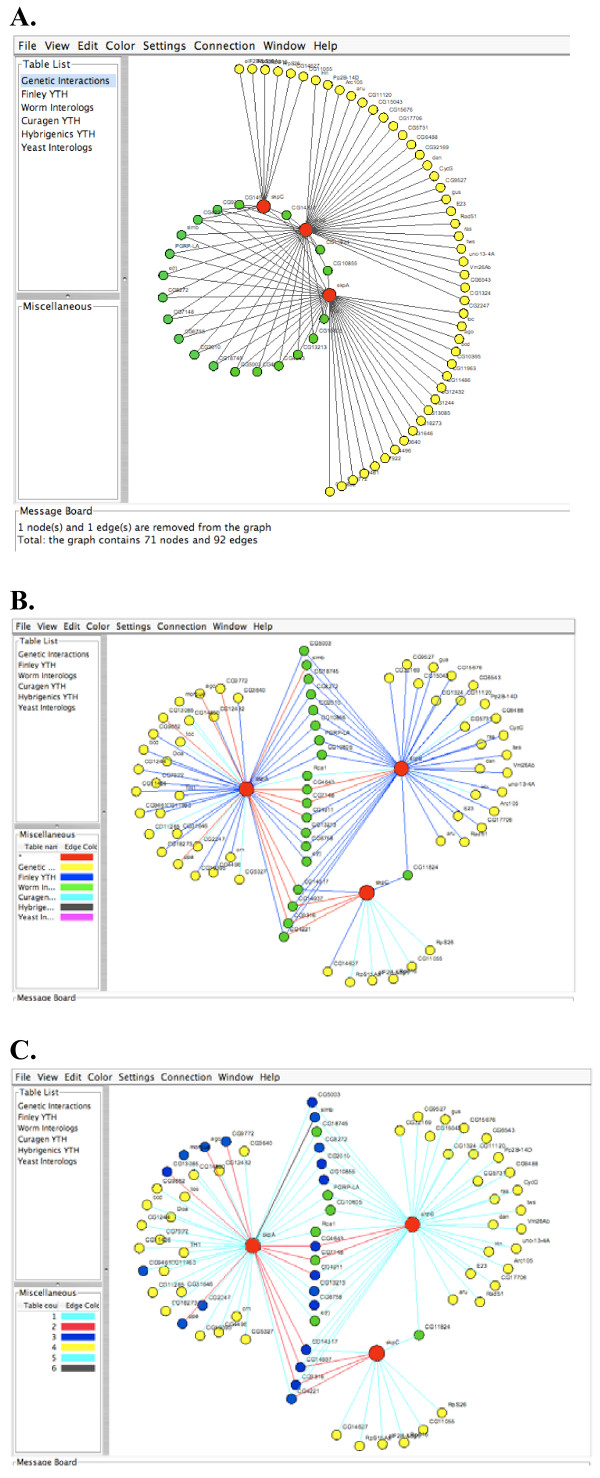
Mining interaction data for biological insights. (A) Circular layout of a map generated by searching the Drosophila Interactions Database for interactions involving 'skp' proteins (colored red). Proteins that interact with two or more Skp proteins are on the circle and were colored green. (B) The map in (A) was redrawn to an 'organic' layout and the edges were colored based on the tables from which the interactions were found. The red edges show interactions found in two or more data sets. (C) The database was searched for proteins that have F-box domains and these were colored blue. Note that a preponderance of the blue nodes can be found in the central group of nodes that interact with two or more Skp proteins.